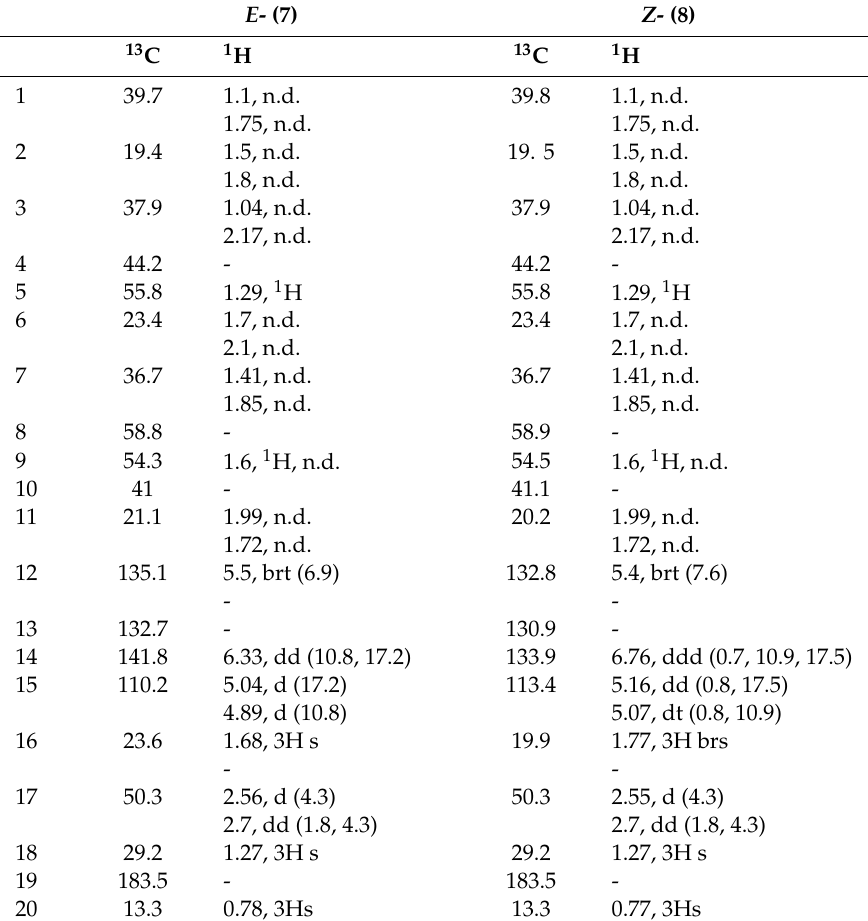
Table 4. 13 C and 1 H NMR spectral data for tentatively assigned compounds. 8 R -17-epoxy- E